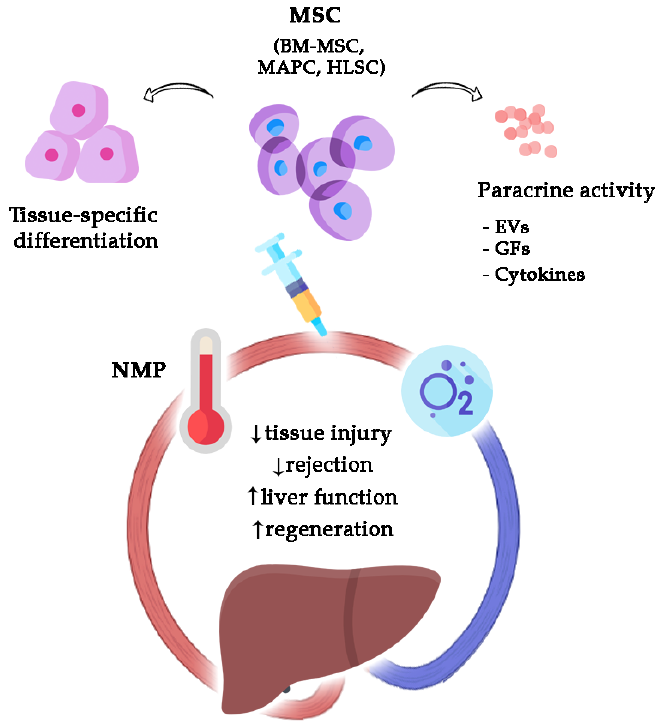
Figure 1. Biological activity of MSC-based therapies administered during liver